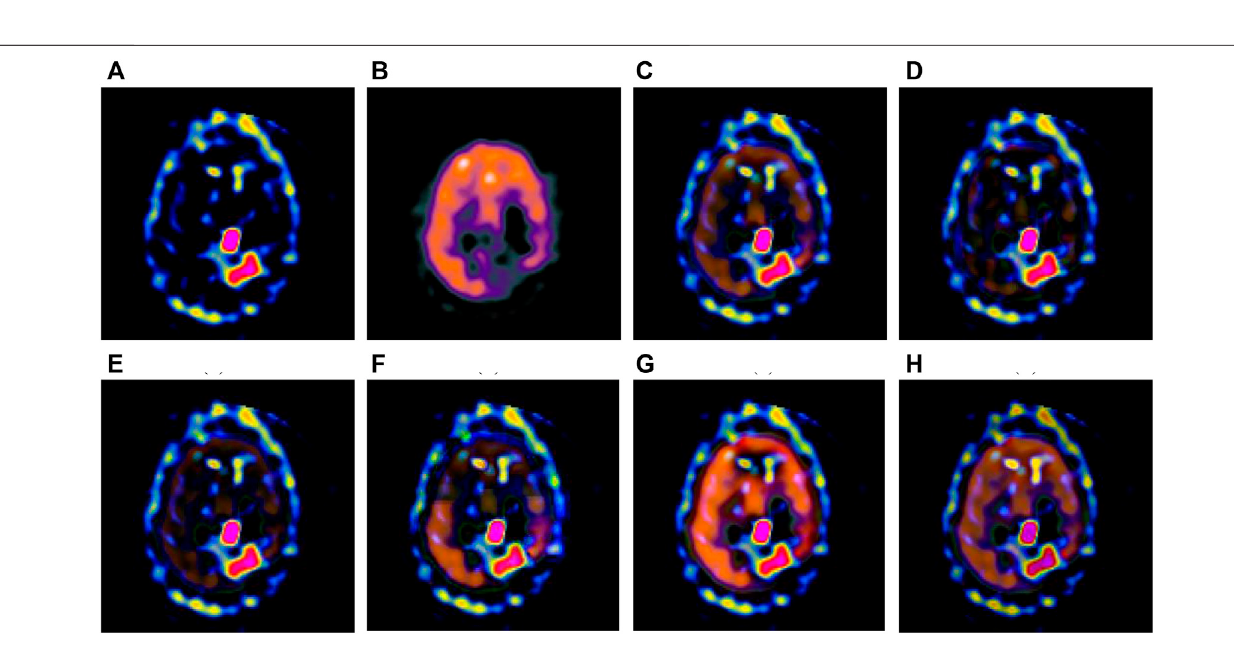
Frontiers in Genetics |